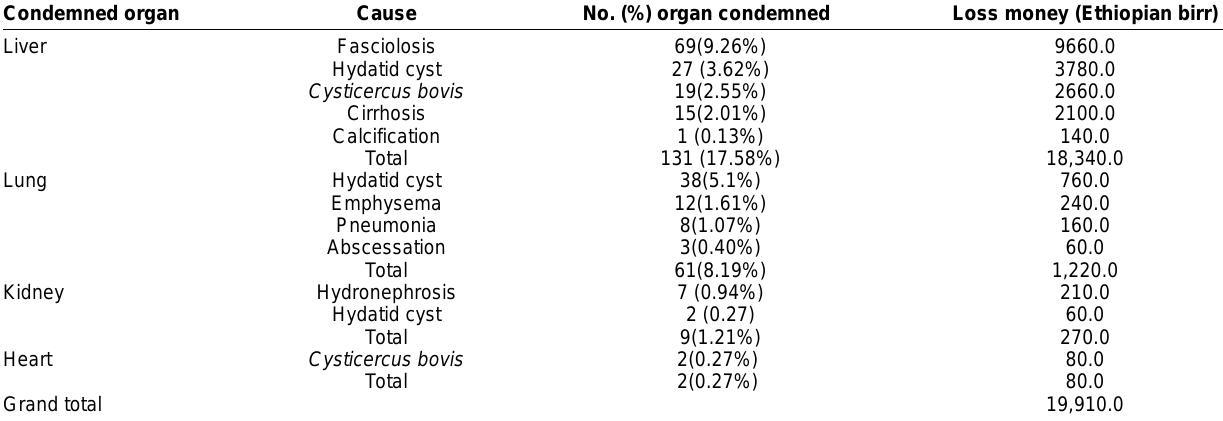
Table-2. Causes, percentage of organ condemnation and economic losses analysis at Adigrat abattoir Condemned organ